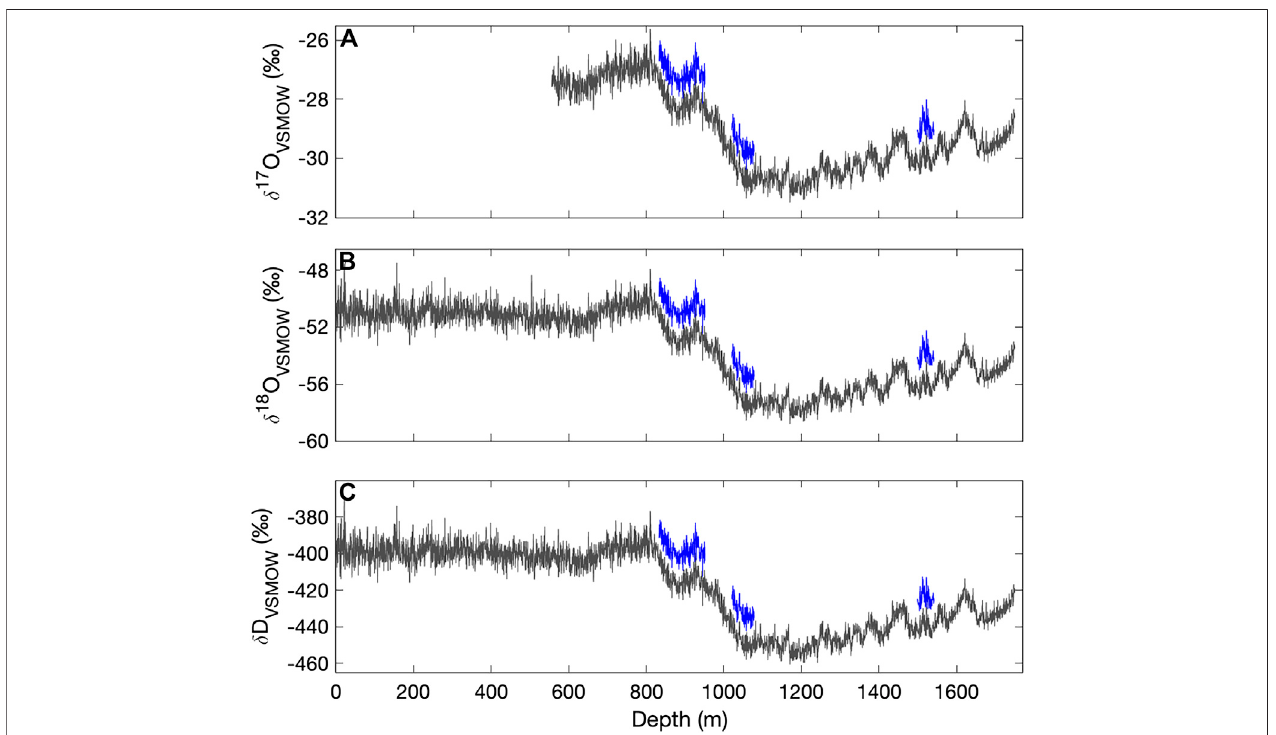
FIGURE3 | Calibrated (A) δ 17 O (B) δ 18 O and (C) δ D for the South Pole ice core (SPC14), from continuous- fl owmeasurements with the Picarro L2140- i (the upper section (to 556 m) wasanalyzed only with the L2130- i ).Dataare shown as 50-cm averages, plotted at their mid-point depth. Replicate data (blue) are offset vertically by 1, 2, and 16 ‰ for δ 17 O, δ 18 O and δ D, respectively.